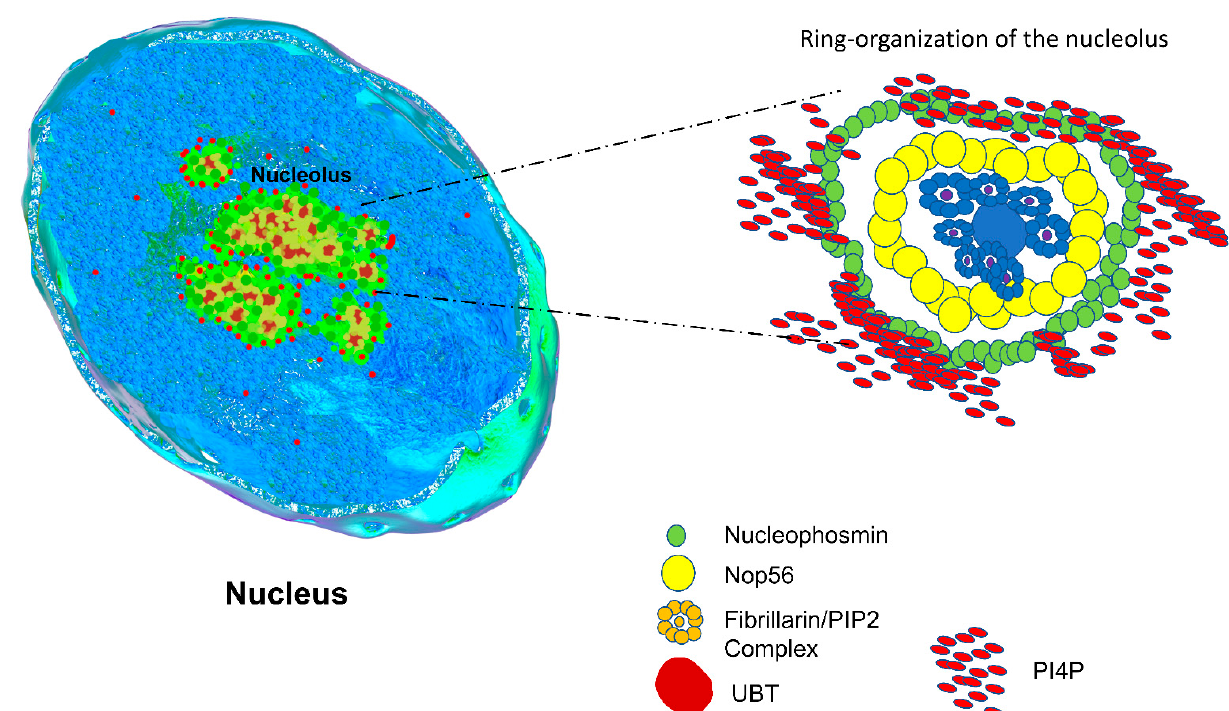
Figure 4. The rim organization of nucleolus. A more current view of the nucleolus as a biocondensate body includes a small-scale organization of specific molecules, as described in other studies for fibrillarin and PIP2 forming small nucleation foci inside the DFC, and also with other phosphoinositides (not shown in the figure). A ring structure appears as a scaffold to confer the properties of a highly dynamic multi-organized nucleolar body.